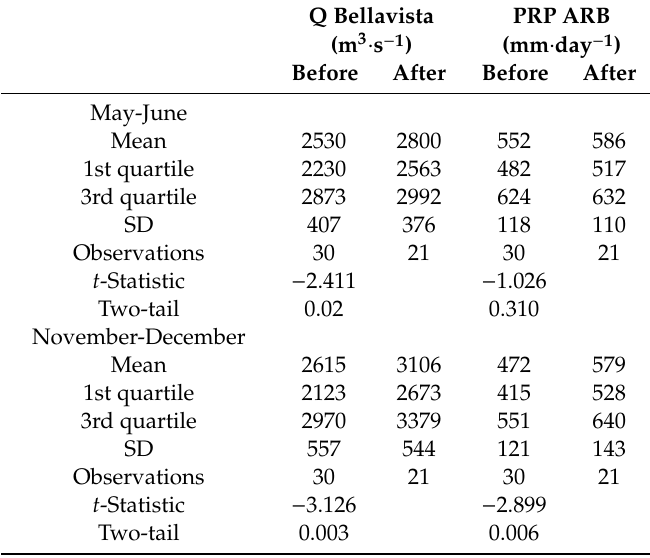
Table 1. Paired t -test for mean streamflow and precipitation before and after 1994 in the high-flow seasons discharge for MJ and ND. Q stands for the streamflow and PRP for precipitation. Q Bellavista PRP ARB (m 3 · s − 1 ) (mm · day − 1 ) Before After Before After May-June Mean 2530 2800 552 586 1st quartile 2230 2563